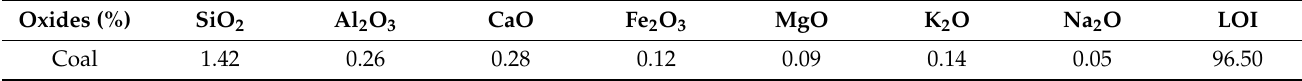
Table 9. Oxide composition of coal.